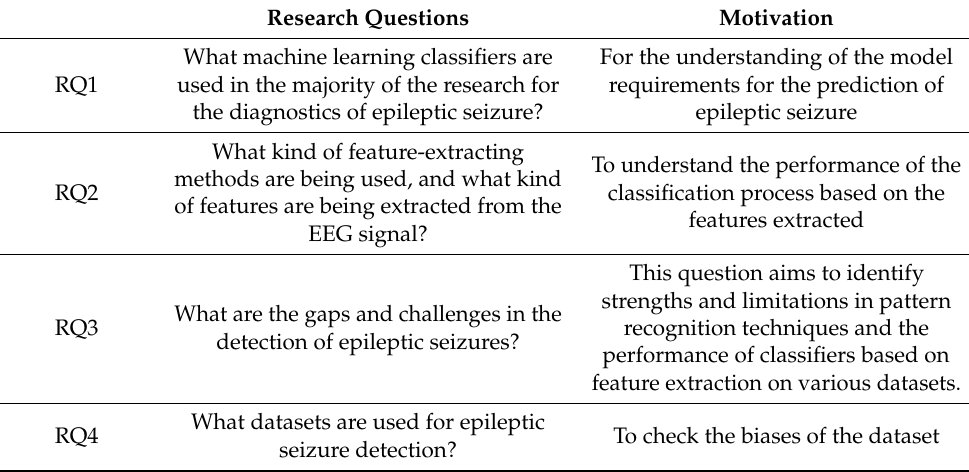
Table 1. Research Questions and the motivation behind